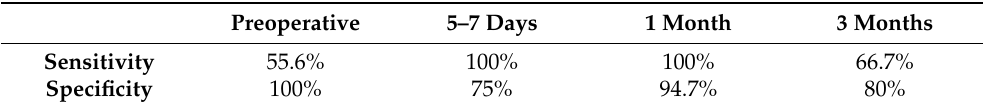
Table 2. Sensitivity and specificity of the Septin 9 test.